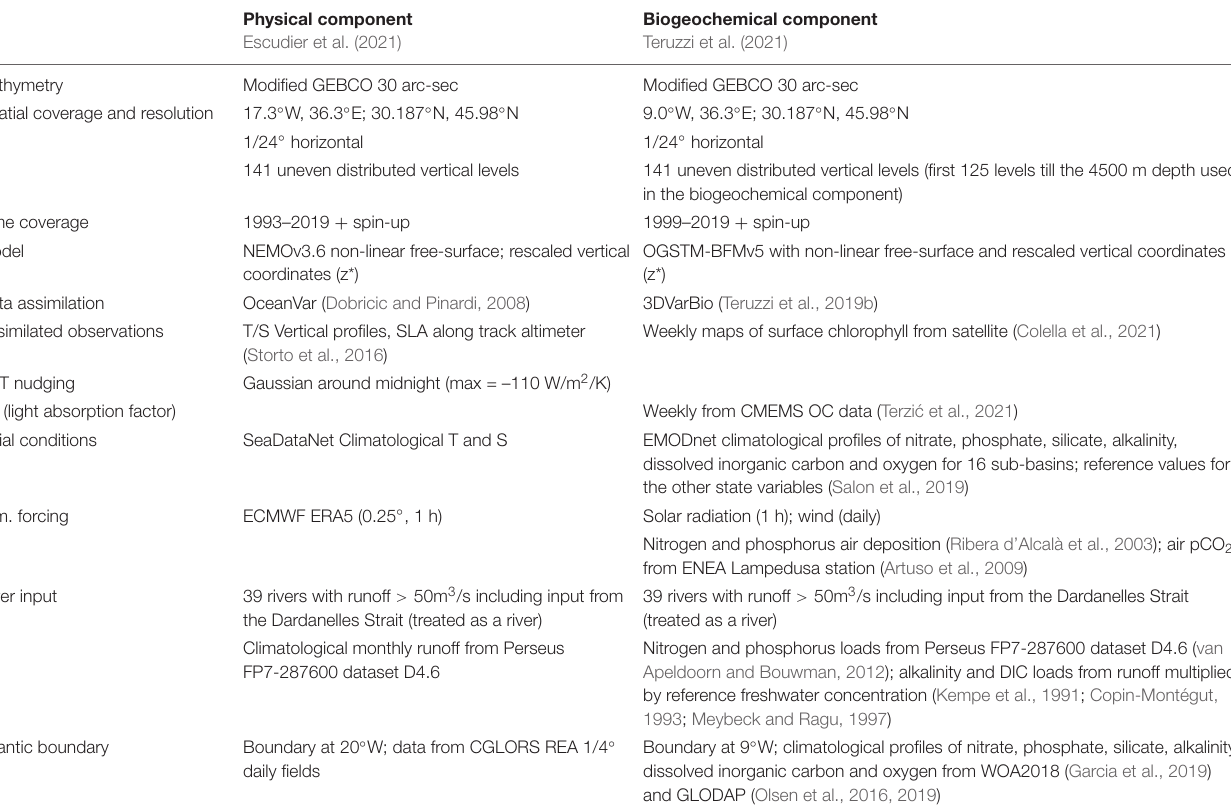
TABLE 1 | Setup of the biogeochemical reanalysis and its off-line coupling with the physical component reanalysis. Physical component Escudier et al. (2021)